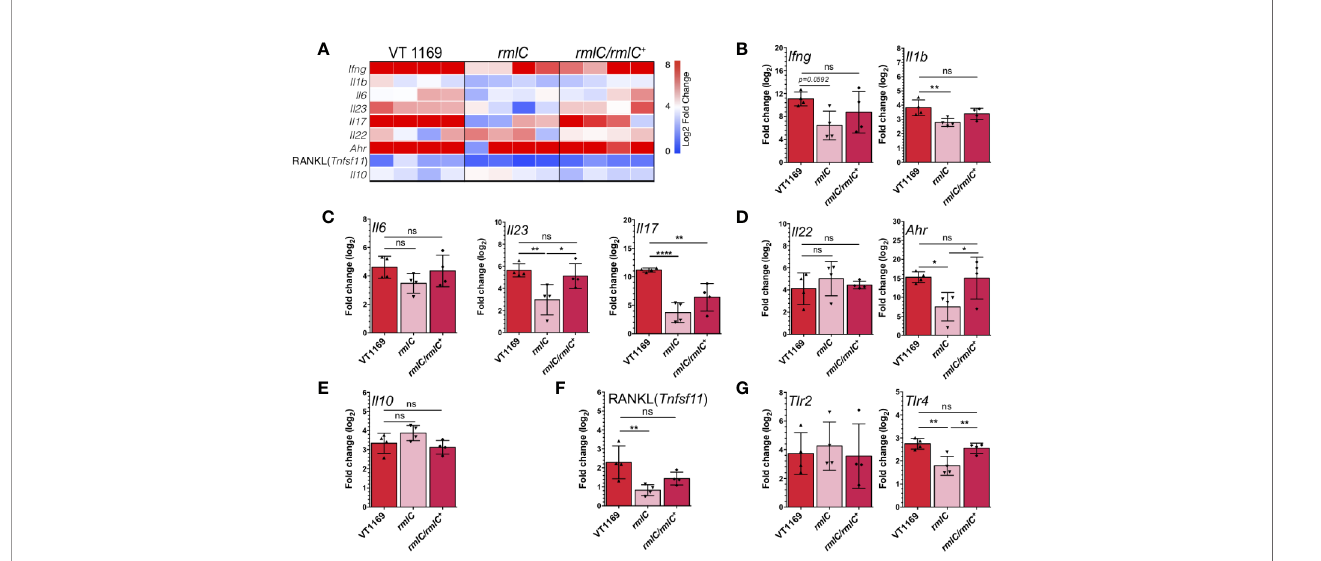
FIGURE 2 | Th1/Th17/Th22-related cytokines, RANKL, and TLR expression within the periodontal tissues induced by the different strains of A. actinomycetemcomitans . (A) Heatmap of mRNA expression levels for Th1, Th17, Th22, and T regulatory-related cytokines and RANKL quanti fi ed by qRT-PCR. Bar plots showing relative expression of (B) Th1-related Ifng and Il1b , (C) Th17-related Il6 , Il17 , and Il23 , (D) Th22-related Il22 and Ahr , (E) T regulatory-related Il10 , (F) RANKL ( Tnfsf11 ), and (G) Tlr2 and Tlr4 mRNAs analyses in periodontal lesions infected with the A. actinomycetemcomitans VT1169, rmlC , or rmlC/rmlC + strains (n=4). The data were pooled from three independent experiments. For relative expression, the mRNA expression in untreated (UT) mice was considered as 0, as a reference for fold-change in expression. Mean ± SD, one-way ANOVA and Tukey post-hoc test, *p < 0.05, **p < 0.01, ****p < 0.0001, ns, non-signi fi cant. Error bars represent SEM in all panels. Ahr , aryl hydrocarbon receptor; Il , interleukin; Ifng , interferon-gamma; Tlr , toll-like receptor; RANKL ( Tnfsf11 ), receptor activator of nuclear-factor k B